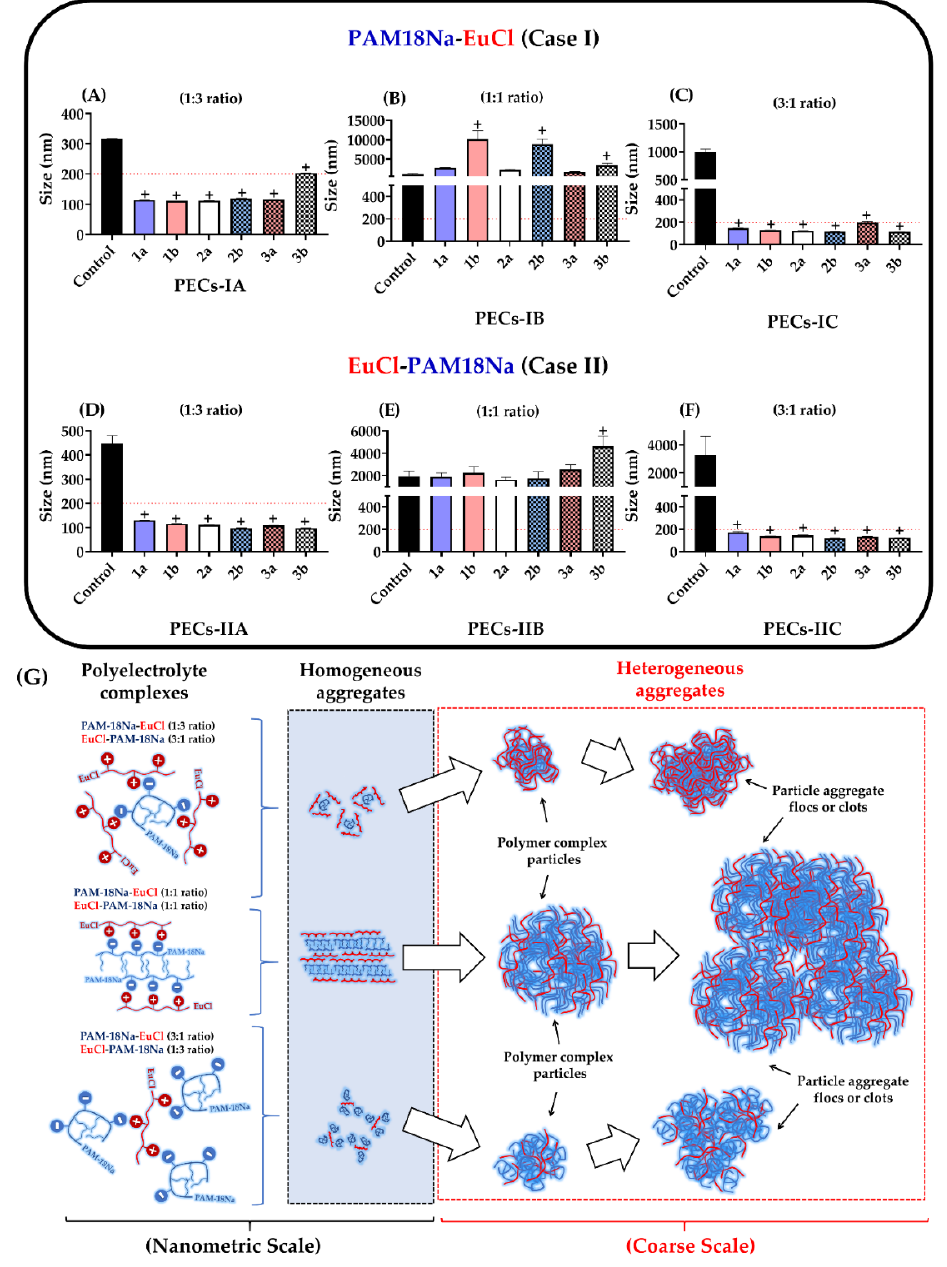
Figure 2. Characterization of particle size for ampicillin-loaded PECs. ( A ) PAM-18Na-EuCl 1:3 ratio. ( B ) PAM-18Na-EuCl 1:1 ratio. ( C ) PAM-18Na-EuCl 3:1 ratio. ( D ) EuCl-PAM-18Na 1:3 ratio. ( E ) EuCl-PAM-18Na 1:1 ratio. ( F ) EuCl-PAM-18Na 3:1 ratio. ( G ) scheme of the polyelectrolytic aggregates formation process in different size scales. The control corresponds to polyelectrolyte complexes obtained initially by polyelectrolytic complexation (bottom-up method) and was not subjected to UHPH (top-down method). “+” significant at P < 0.05.